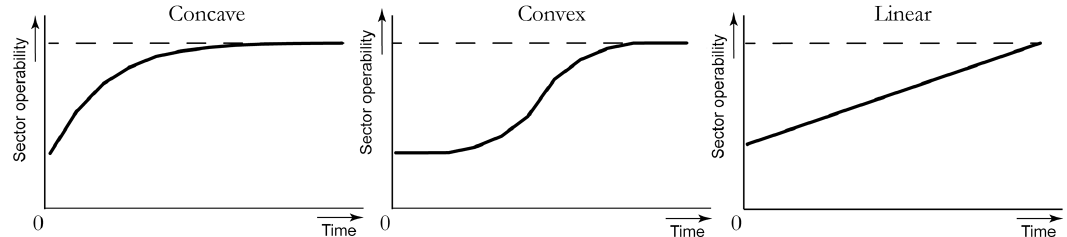
Figure 2. Three recovery curves used in this